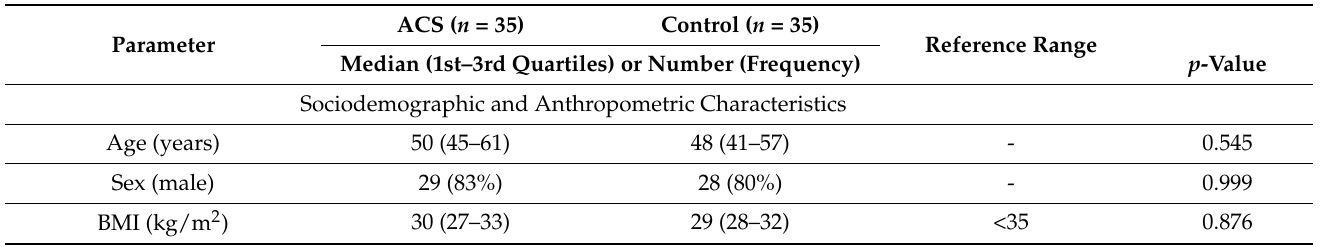
Table 1. Sociodemographic, anthropometric, and blood biochemical characteristics of ACS patients and healthy